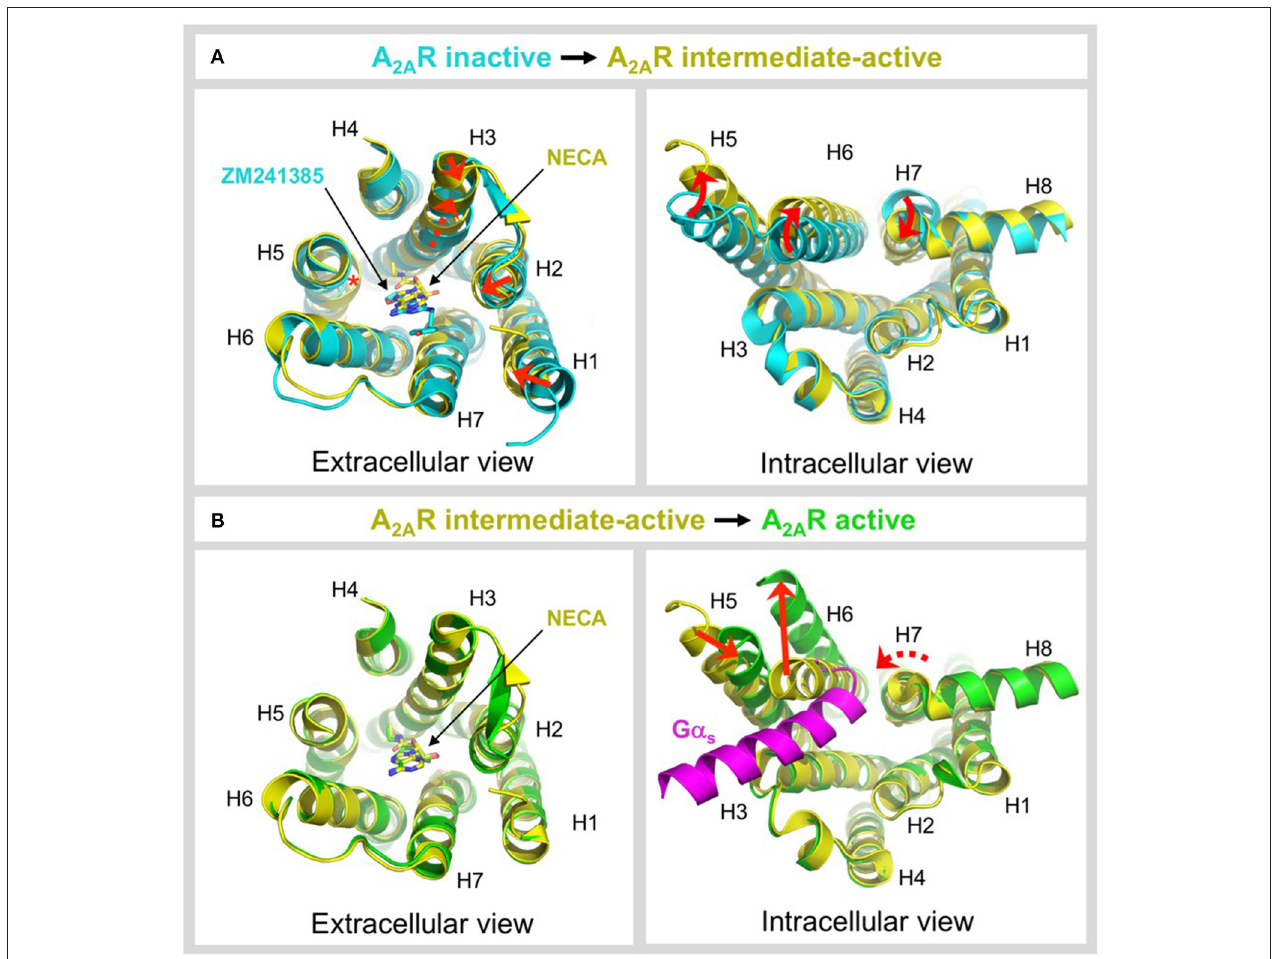
FIGURE 5 | Ligand-induced activation of A 2A R. (A) Conformational changes associated with agonist-induced transition from the inactive state (colored cyan) to the intermediate-active state (colored yellow; PDB: 2YDV) ( Lebon et al., 2011b). Two different inactive state structures were used for the alignments, the extracellular view uses 4EIY (Liu et al., 2012) because it is the highest resolution non-thermostabilized structure available, the intracellular view uses 3PWH (Doré et al., 2011) because it was crystallized without a fusion protein in ICL3. The extracellular view shows the 1–2 Å inward shifts in the ends of H1, H2, and H3 (indicated by a red arrows), the 2 Å translocation of H3 along its axis (indicated by a dashed red arrow), and the inward bulge in H5 (indicated by a red asterisk). The inverse agonist ZM241385 (colored cyan) and agonist NECA (colored yellow) are shown as sticks. The intracellular view shows the combined rotational and lateral movements in H5, H6, and H7 (indicated by curved red arrows). H5 and H6 are displaced outwards by 7 and 5 Å, respectively, while H7 moves inwards in by 4 Å. (B) Conformational changes associated with G protein-induced transition from the intermediate-active state (colored yellow; PDB: 2YDV) (Lebon et al., 2011b) to the active state (colored green; PDB: 5G53) (Carpenter et al., 2016). No significant changes are observed on the extracellular side of the receptor, and the position of NECA (shown as sticks) is essentially identical in both states (Carpenter et al., 2016). On the intracellular side of the receptor an outward movement of H6 by 14 Å (indicated by a red arrow) is required to accommodate binding of mini-G s (colored magenta). H5 moves inwards by 5 Å (indicated by a red arrow) and forms direct contacts the α 5 helix of mini-G s . H7 undergoes a rotation, without significant lateral movement (indicated by a curved and dashed red arrow), which reorients the H7-H8 boundary to interact with the C-terminus of mini-G s (Carpenter et al., 2016). Note that for clarity, ECL2 has been omitted from the extracellular view of all